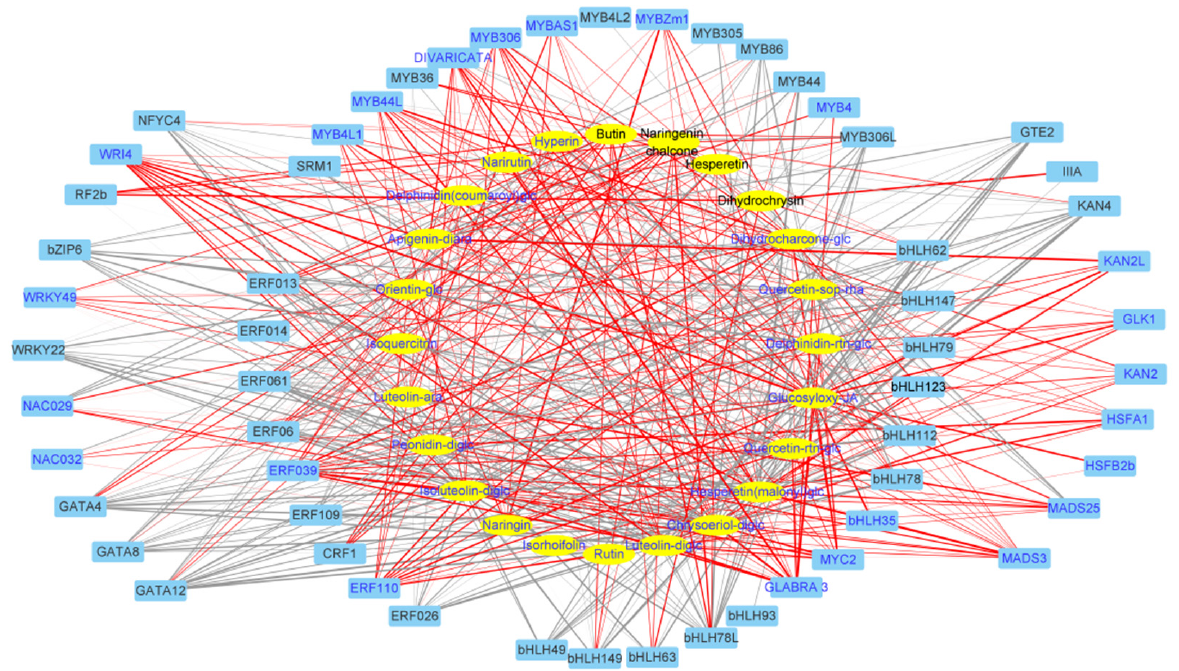
Figure 5. The network of differentially expressed TFs and light- and K-altered flavonoids in D. officinale. Metabolites are in the yellow ellipse and TFs in the blue box. The upregulated TFs or flavonoids were in blue font and those downregulated in black font. For the connection between genes and metabolites, the red lines indicated a positive correlation while the gray lines indicated a negative correlation. The treatment-altered pattern and annotation of metabolites or TFs were given in Table